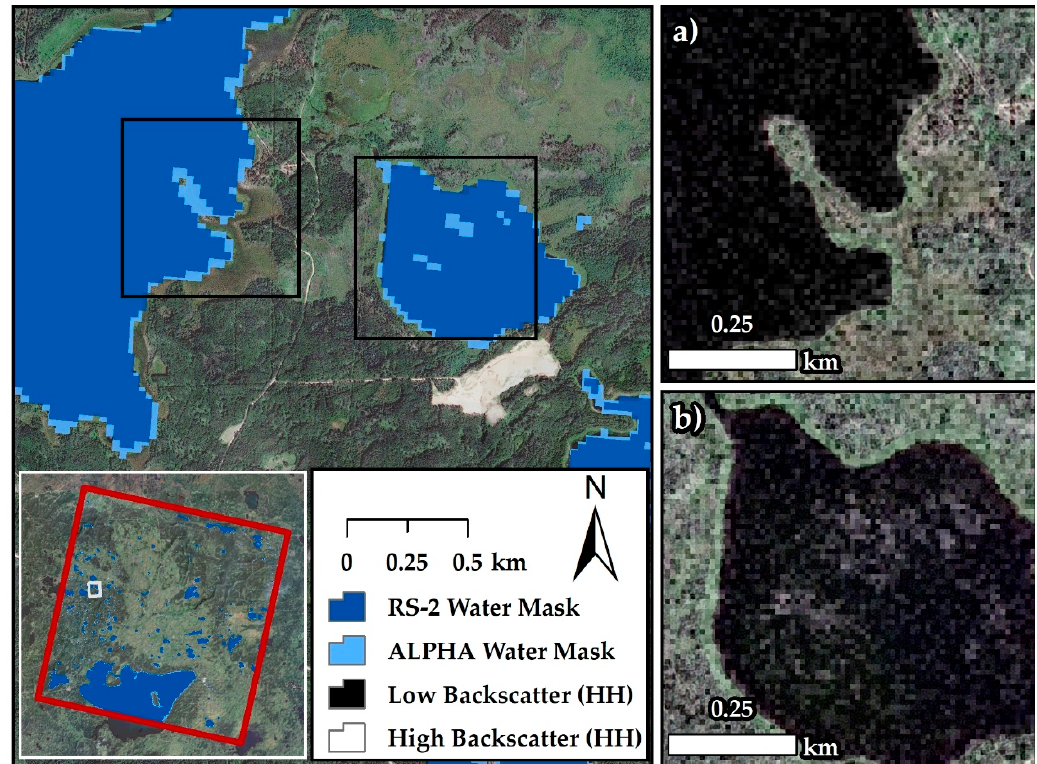
Figure 6. Visual comparison of the most accurate derived water mask from Radarsat-2 data and the Advanced Landcover Prediction and Habitat Assessment (ALPHA) wetland inventory product.